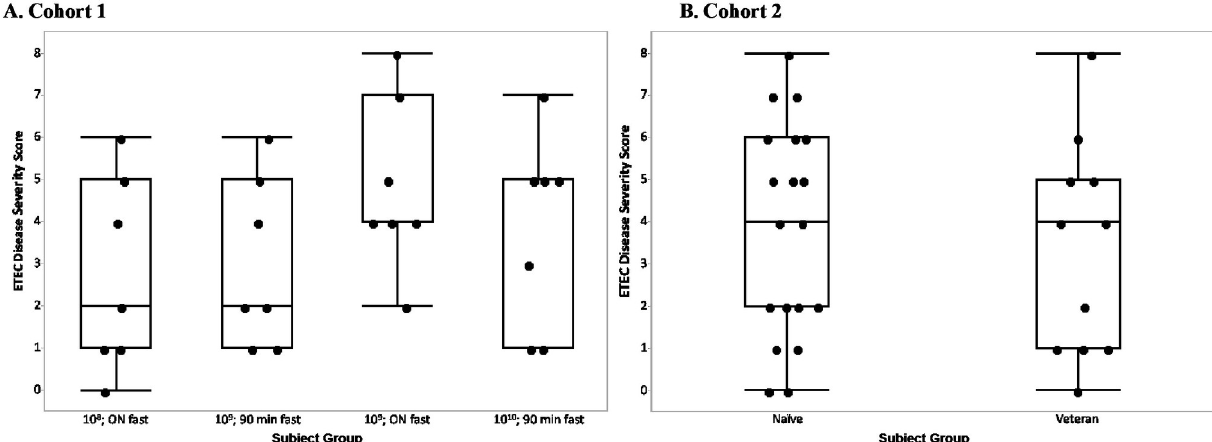
Fig 2. The disease severity score for each subject is represented by a dot on the figure based on (A) the dose and fasting time to which that subject was randomized in Cohort 1 or (B) veteran status of the subject in Cohort 2. The horizontal line within the box represents the median sample value. The ends of the box represent the 1st and 3rd quartile. The whiskers extend from the ends of the box to the outermost data point that falls within the distances computed as 1st/3rd quartile—1.5 � (interquartile range).